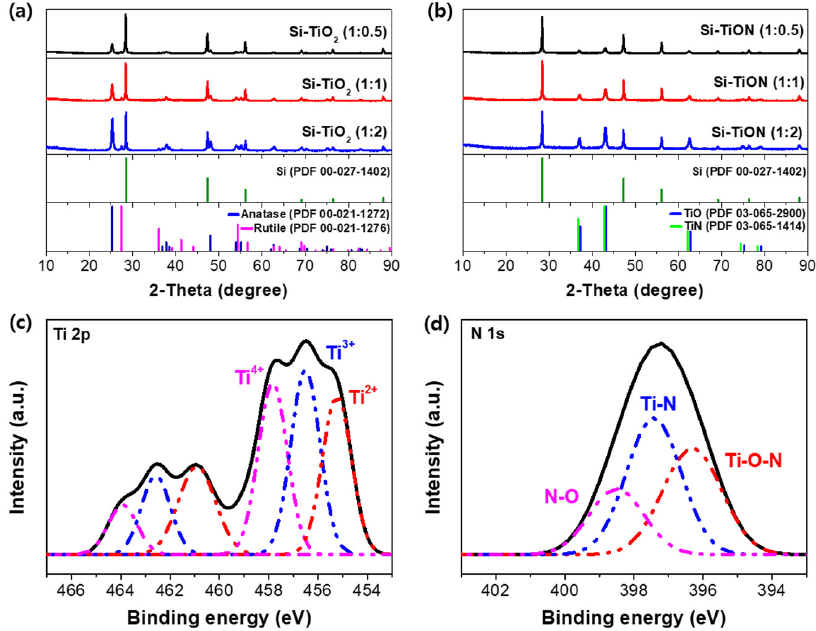
Figure 4. XRD patterns of ( a ) Si-TiO 2 prepared by the spray-drying process and ( b ) subsequently nitrided Si-TiON composite with ratios of 1:0.5, 1:1, and 1:2. ( c , d ) X-ray photoelectron spectra for Si-TiON (1:1) composite in the region of binding energies of Ti 2p and N 1s core levels.